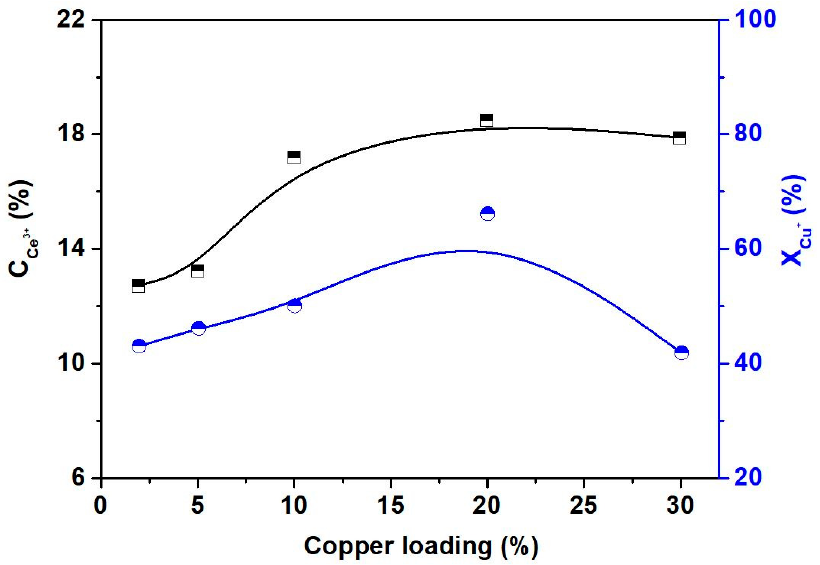
Figure 22. Mole ratio of Ce 3+ and Cu + over the reduced Cu/CeO 2 catalysts as a function of Cu content. Adapted from Reference [306]. Copyright © 2018, John Wiley and Sons.